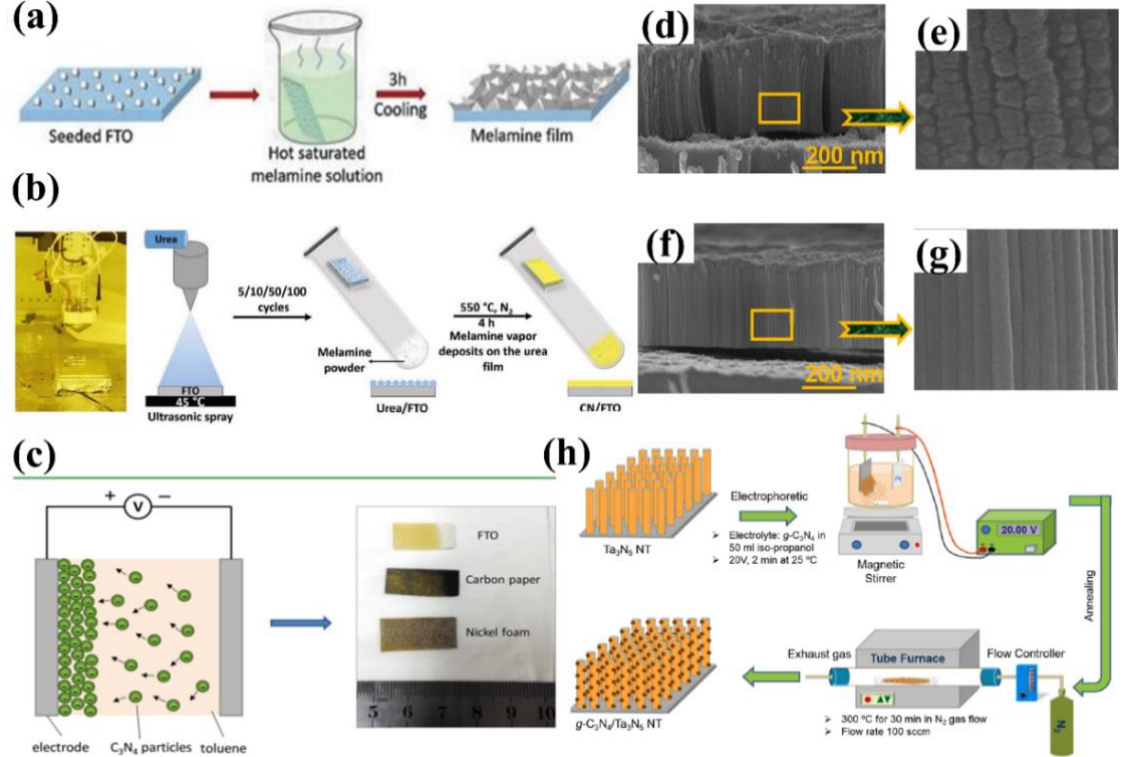
Figure 7. ( a ) Schematic illustration of the synthesis of melamine film, reprinted with permission